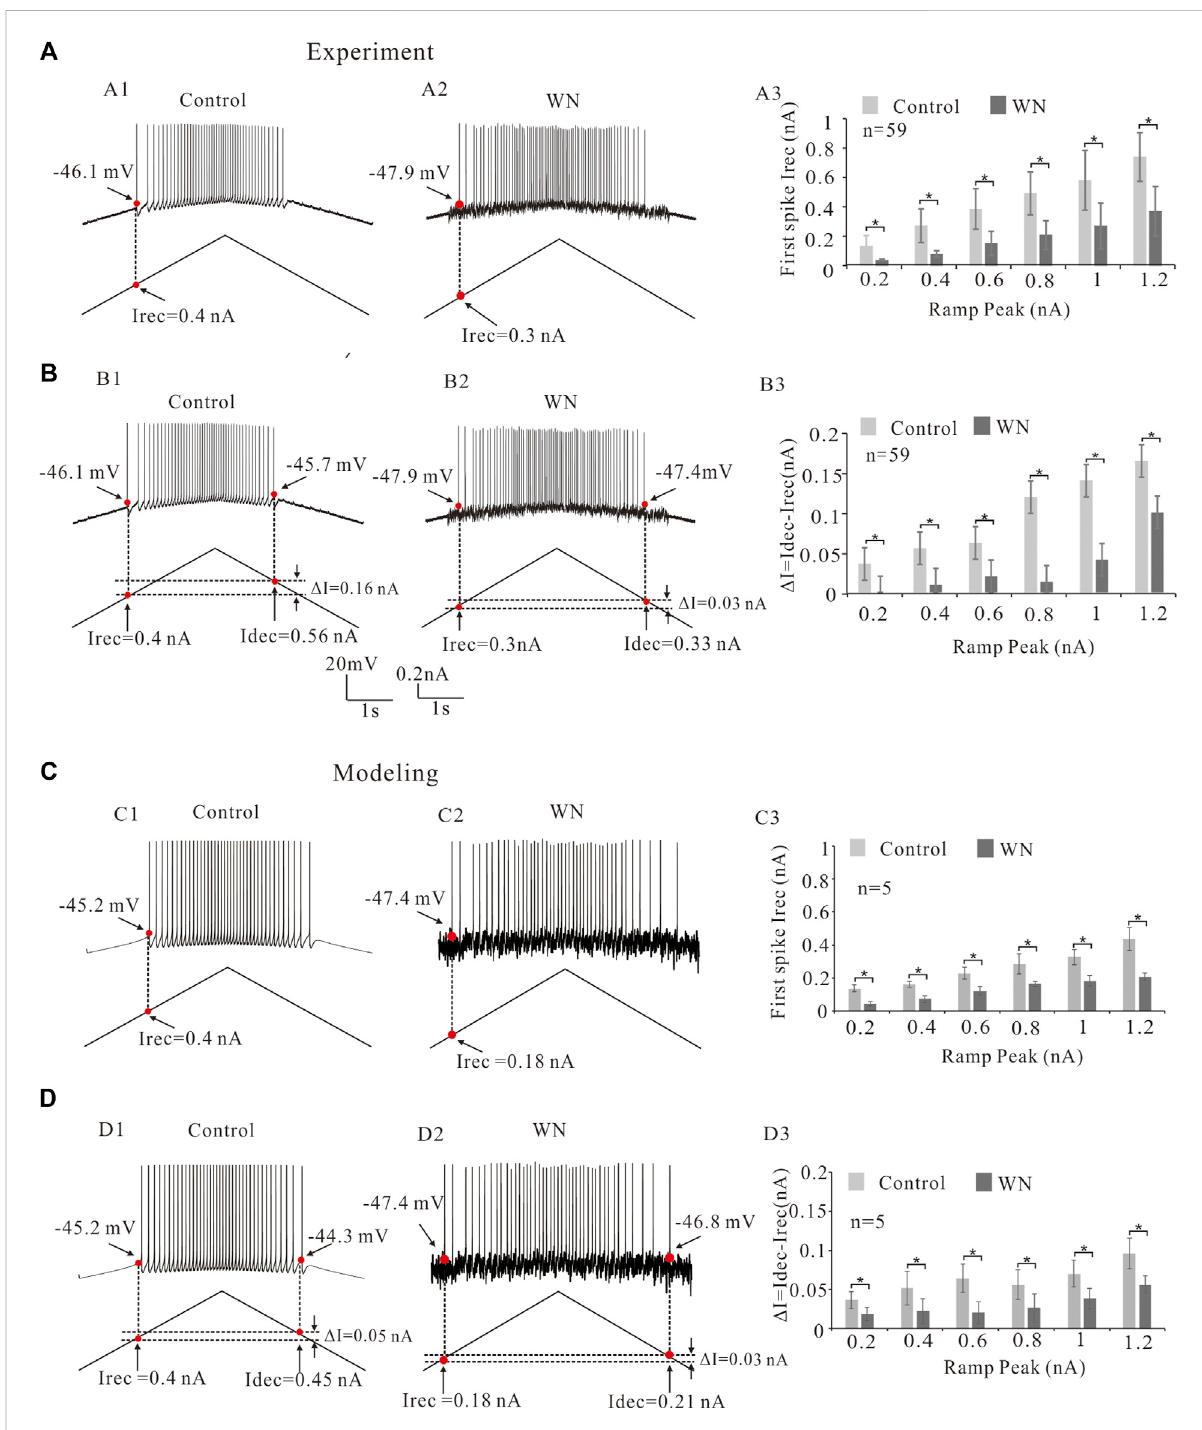
FIGURE 3 Effectofwhitenoiseonrecruitmentcurrent(I rec ). (A) Repetitive fi ringswereevokedbycurrentbi-rampsincontrol (A1) andwhitenoise (A2) and current thresholds (I rec ) were recorded (red dots). White noise reduced the I rec ( A1 vs. A2 ). Statistical results showed that the white noise signi fi cantly reduced theI rec of the repetitive fi ring and this reduction of I rec was slope-dependent (A3) . (B) Recruitment, decruitment currents (red dots in B1,B2 ) and Δ I = I dec - I rec were calculated. White noise reduced Δ I ( B1 vs. B2 ). Statistical results indicated that the white noise signi fi cantly reduced Δ I (B3) . The reduction of Δ I was slope-dependent. (C) Similar results were obtained from modeling data. Similarly, repetitive fi rings were generated by current bi-ramps in control (C1) and white noise (C2) . Recruitment current (I rec ) were recorded (red dots). White noise reduced the I rec ( C1 vs. C2 ). Statistical results indicated that white noise signi fi cantly reduced the I rec (C3) . The reduction of I rec was also slope-dependent. (D) : Recruitment, decruitment currents (red dots in D1 and D2 ) and Δ I = I dec - I rec were calculated from the repetitive fi rings in control (D1) and white noise (D2) . White noise reduced Δ I ( D1 vs. D2 ). Statistical results showed that the white noise signi fi cantly reduced Δ I (D3) , and the reduction of Δ I was shown to be slope-dependent. Data are expressed as mean ± SD. Paired t -test was performed. * p <